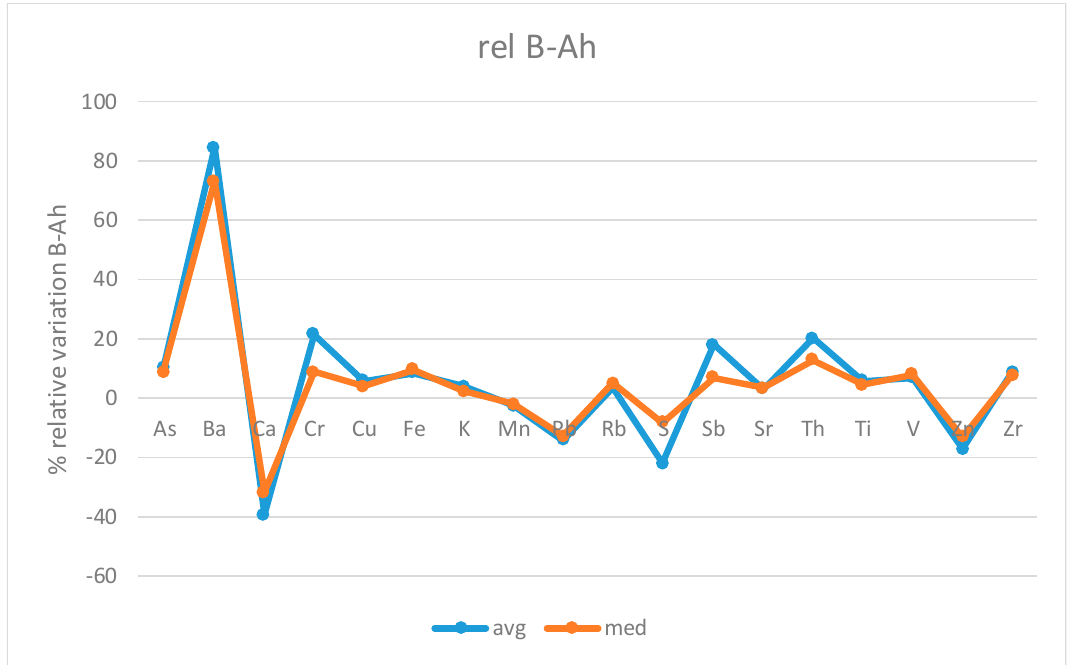
Figure 11. B vs. Ah enrichment factors by element (B concentration/Ah concentration, averaged pXRF raw data for all points).